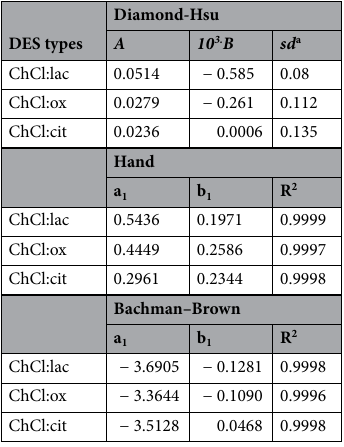
Table 5. The values of parameters of Diamond-Hsu, Hand and Bachman–Brown equations with the standard deviation of the models, sd , for the {PPG400 + ChCl(HBA) + carboxylic acids(HBD) + H 2 O} at 298.15 K and atmospheric pressure (≈ 85